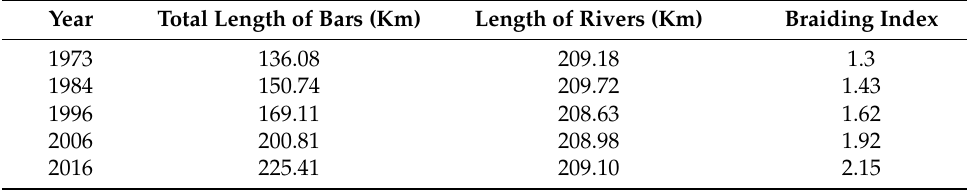
Table 3. Measurement of Braiding Index of Ganges-Padma River during